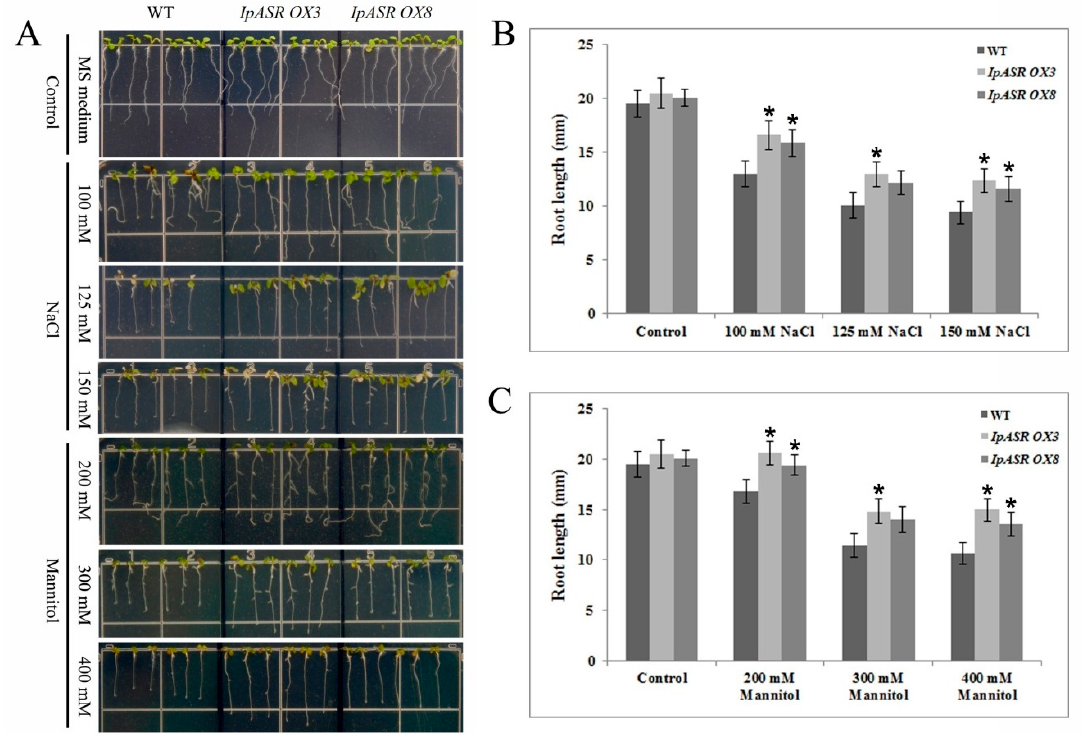
Figure 10. Osmotic and salt stress analyses of transgenic plants with IpASR based on seedling root length. Four-day-old seedlings were transplanted into MS medium containing NaCl or mannitol and then grown for 7 d before measuring the root length. ( A ) Photographs of transgenic lines ( IpASR OX3 and IpASR OX8 ) and WT seedlings on MS medium or MS medium with NaCl (100, 125 and 150 mM) or mannitol (200, 300 and 400 mM); ( B , C ) Seedling root length (mm) in WT and transgenic lines under NaCl ( B ) and mannitol ( C ) stress after 7 days. Error bars indicate the SD based on over three replicates ( n ≥ 3). Asterisks indicate significant differences from the control (Student’s t -test p values, * p < 0.05.